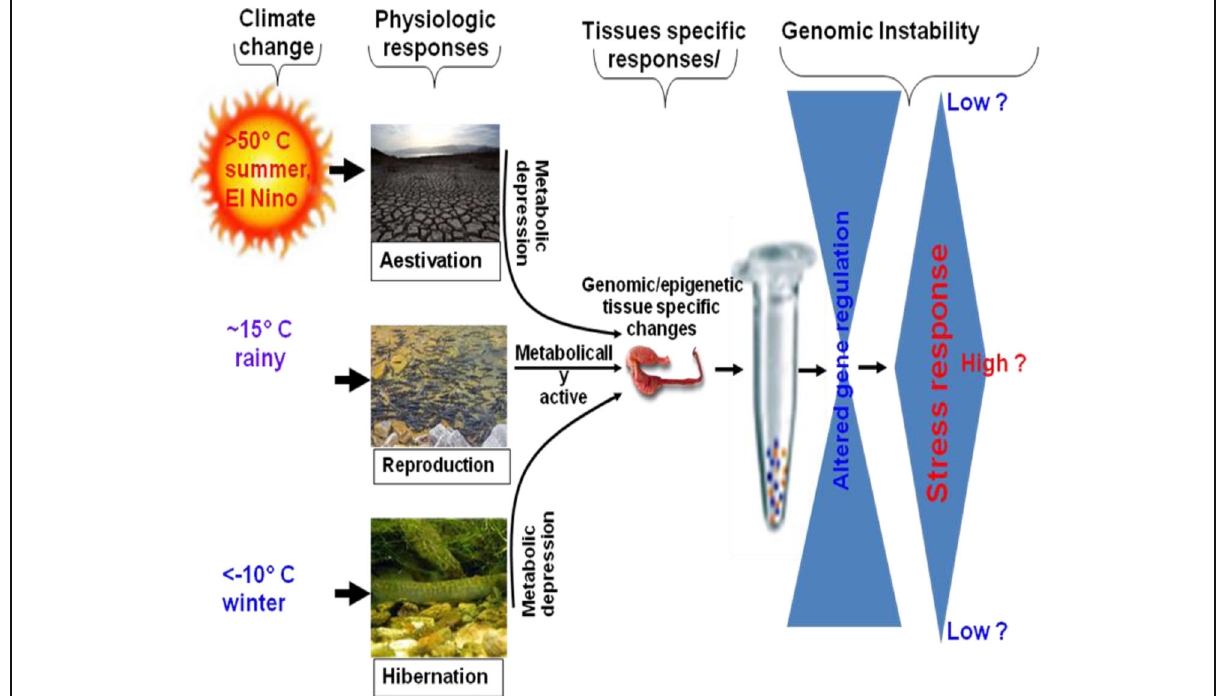
Fig. 3 Climatic factor can lead to genomics instability via physiological tissue-specific responses in aquatic organisms as a function of several lively